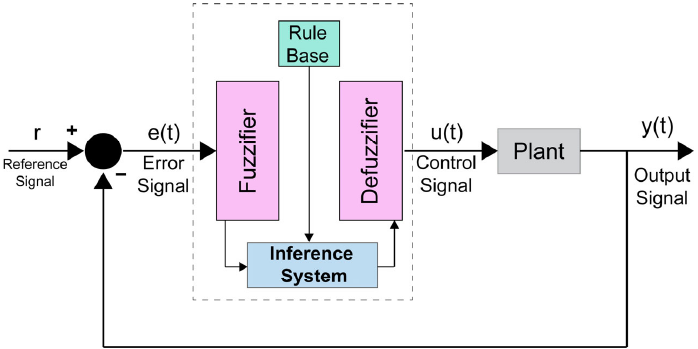
Figure 4. Fuzzy decision ‐ making model. The fuzzy controller includes four elements: the inference system, rule base, defuzzifier interface, and fuzzifier interface. The output signal is the IoT device’s status or AR message values.